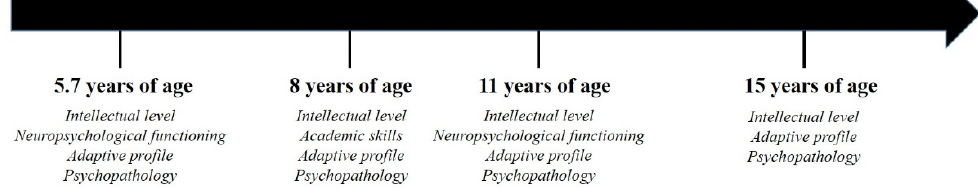
Figure 4. Timeline of the neuropsychological and behavioral evaluations.